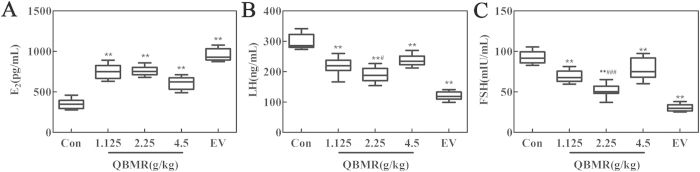
The effects of QiBaoMeiRan formula (QBMR) on serum estradiol (E2), luteinizing hormone (LH), and follicle-stimulating hormone (FSH) in immature mice. Serum levels of E2 (A), LH (B), and FSH (C) were measured at the end of the treatment period. Data are the mean ± standard deviation (SD) of samples from 10 rats. P values are based on the results of a one-way ANOVA comparing the treatment group with untreated immature mice. **p < 0.01, compared to the control group. ###p < 0.001, #p < 0.05, compared with QBMR 1.125 g/kg group.